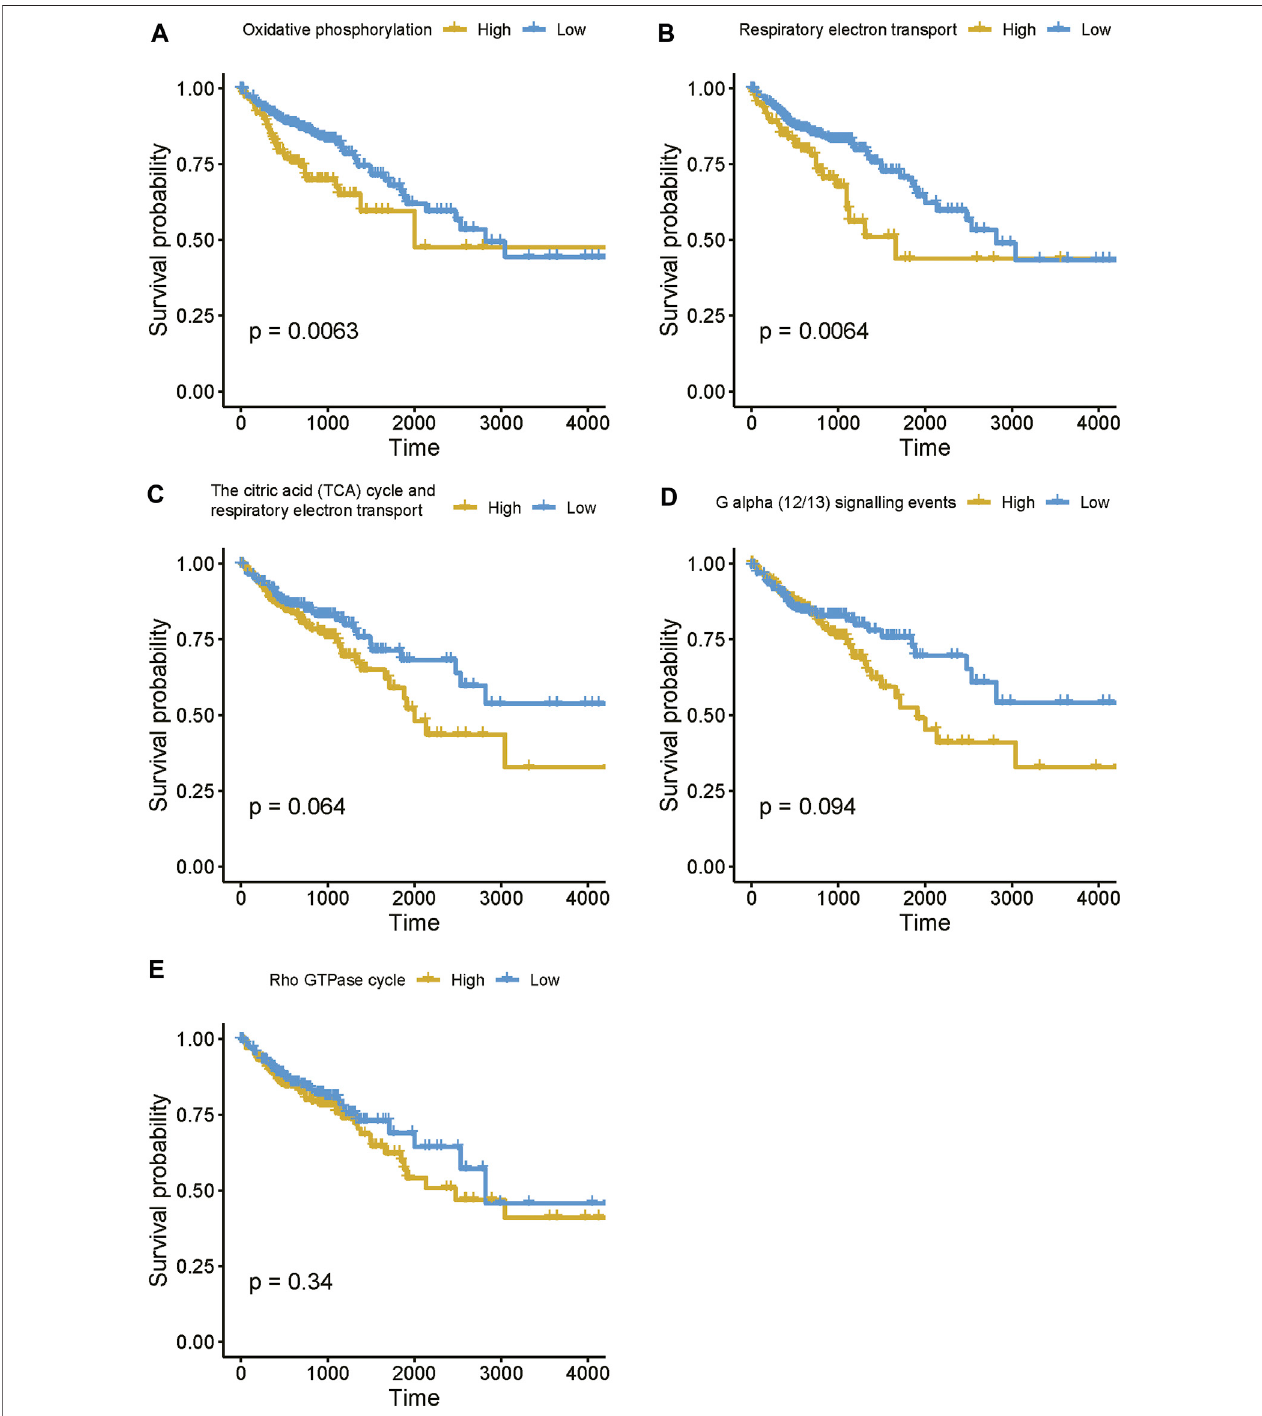
FIGURE8| TheestimatedactivitiesofthelncRNA-relatedpathways. (A – E) ThesurvivalcurvesfortheCOADpatientswithhighandlowactivitiesoflncRNA-relatedpathways.